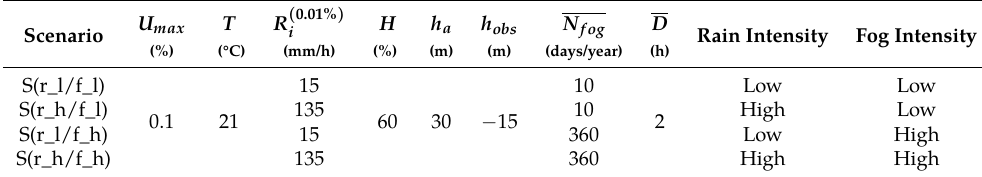
Table 7. Characteristics of the test scenarios.